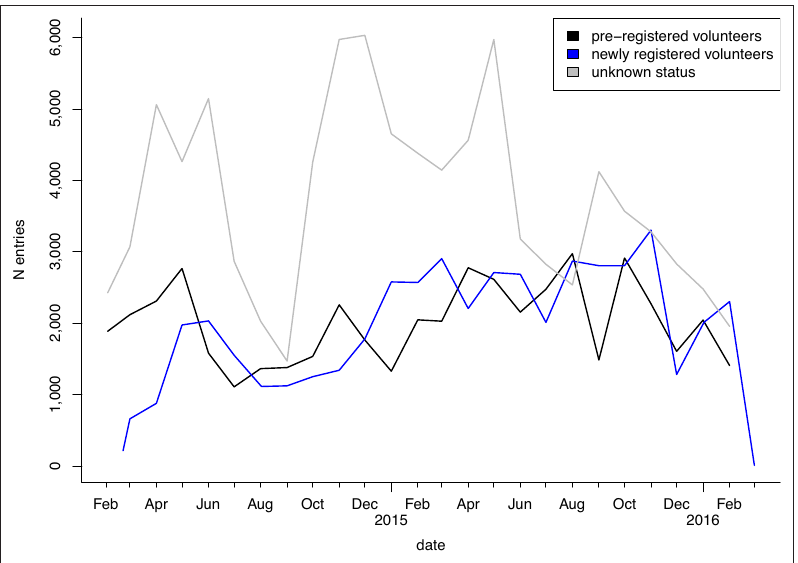
Figure 4: Total entries per month by type of volunteer: Those who had registered at velehanden.nl before the project started (pre-registered), volunteers who registered during the project (newly registered), and volunteers who did not make their registration date public (unknown).